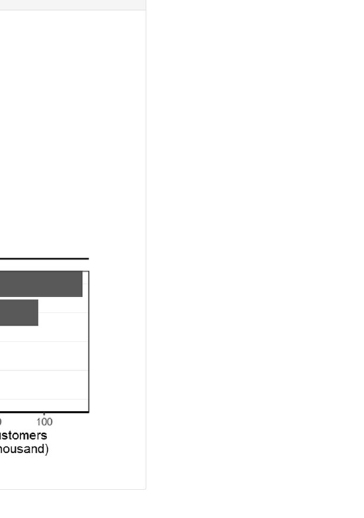
Fig 8. Screenshot of item combinations (UpSet plot)